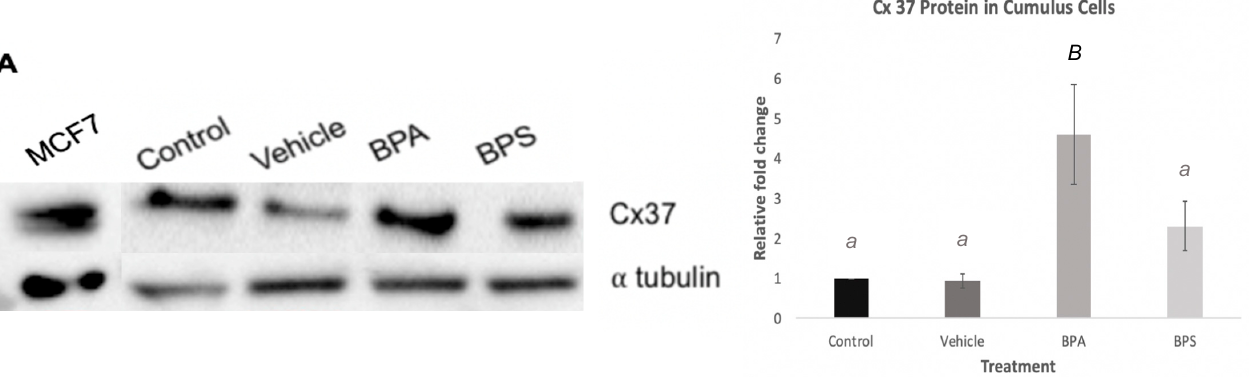
Figure 8. Connexin protein expression in bovine cumulus cells. ( A ) Blot showing protein expression of Cx37 after 24-h treatment with BPA and BPS ( B ) Densitometry analysis for 3 biological replicates, depicting the relative fold change of Cx37 protein expression for each treatment groups as compared to the controls. Letters indicates statistical significance at p < 0.05, BPA ( p < 0.01, n = 6).